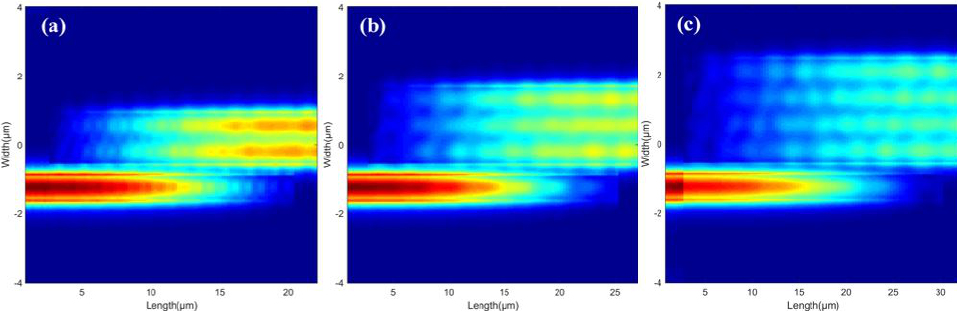
Figure 2. Simulated light propagation in the coupling regions of ADCs mode (de)multiplexer when the launched TE 0 mode of the access waveguide couples to the ( a ) TE 1 , ( b ) TE 2 , and ( c ) TE 3 mode in the bus